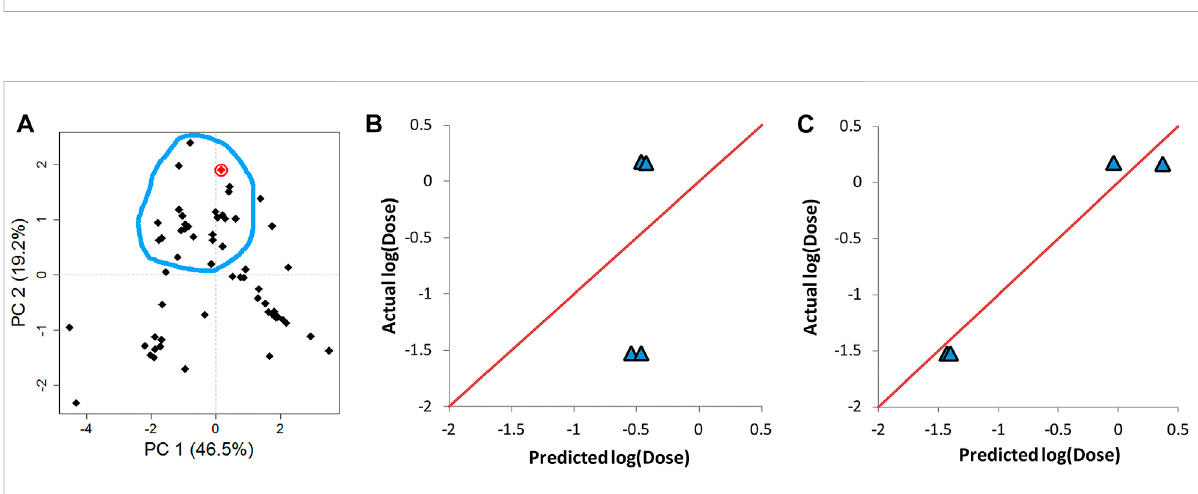
FIGURE 7 Determinationoftheapplicabilitydomain(AD)offourlipidsfromvalidationsetone. (A) PCAoftrainingsettogetherwithoneofthevalidationset lipids (lipid 15) shown in red circle. (B) The actual vs predicted plot before determining AD. (C) The actual vs predicted plot after determining AD. Predictions in C and B are carried out by ANN. The red line in B and C represents perfect correlation between actual and predicted